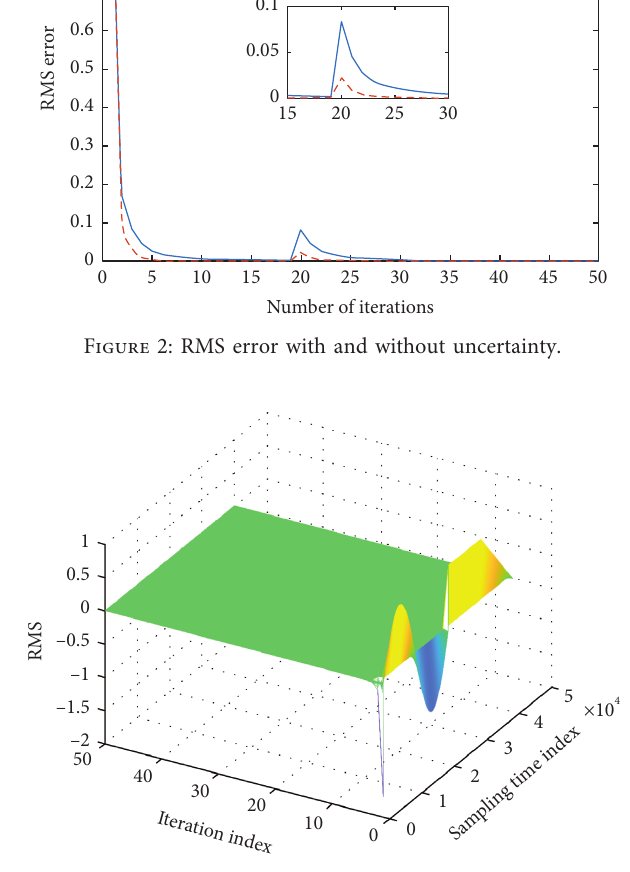
Figure 3: RMS error in time and iteration